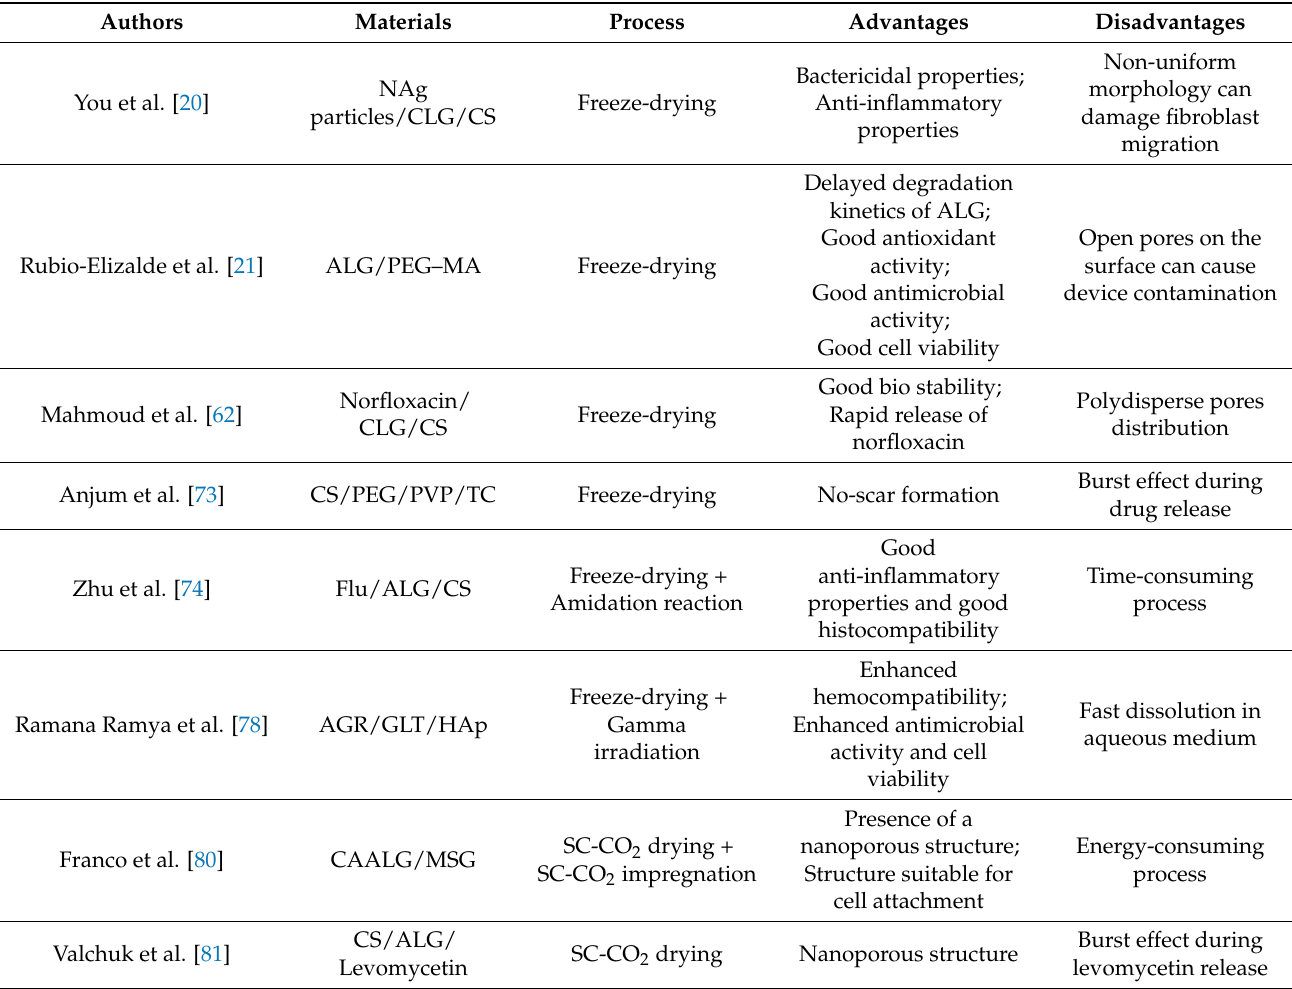
Table 1. Gels applied to skin